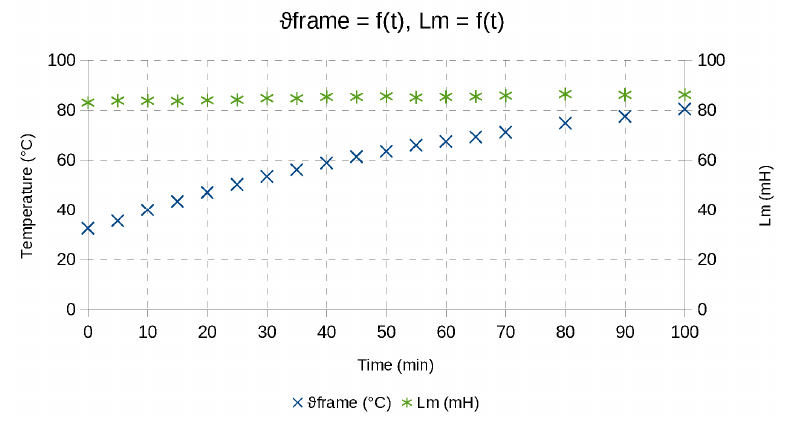
Figure 6. L m and machine frame temperature ϑ frame in the course of time during warming test.